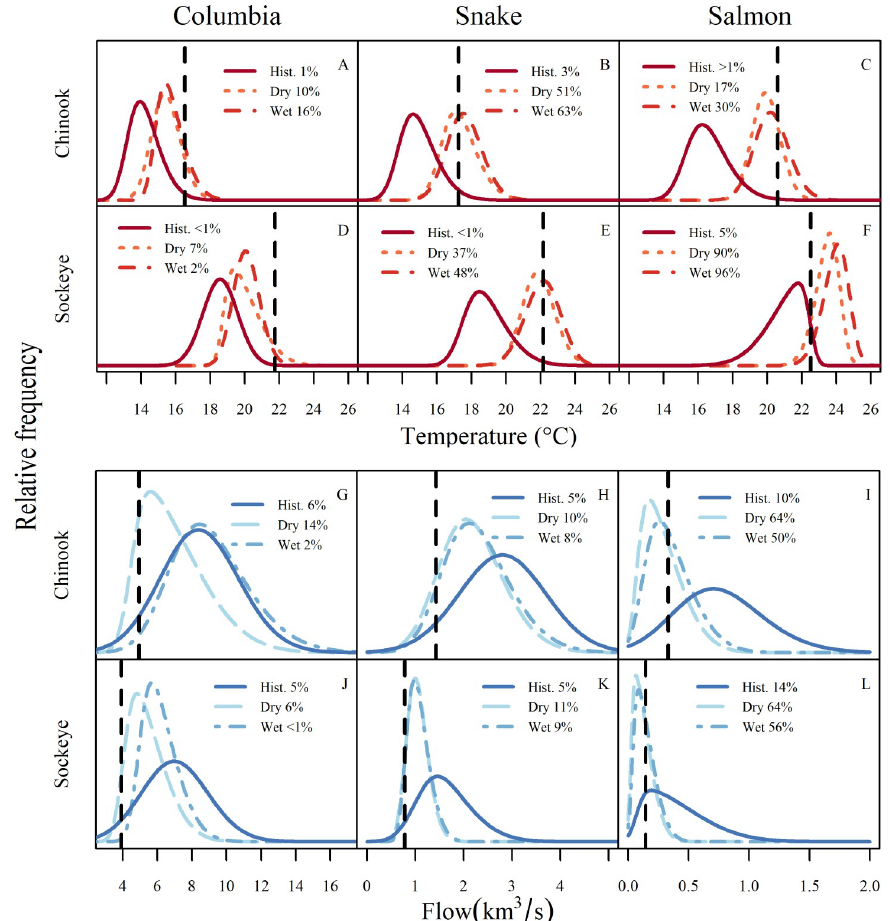
Fig 5. Predicted frequency of mean temperatures (A-F) and flows (G-L) averaged during the Chinook and sockeye runs (5-95 th quantiles of observed reach entry dates) for climate scenarios. Means for 2015 are shown as dotted vertical lines. To smooth the distribution of annual temperatures and flows for plotting, we fit a skewed normal distribution for each climate change scenario. The frequency of years as extreme as 2015 is shown in each